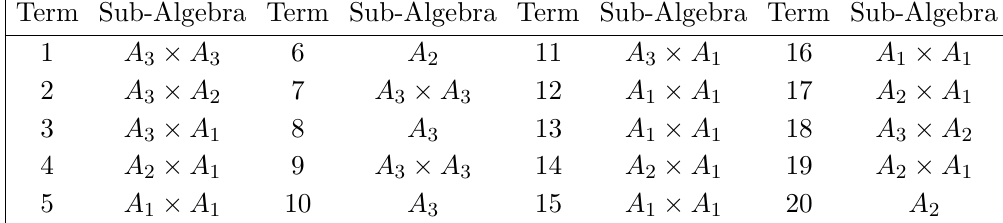
Table 4. Subalgebras associated to terms in A 8 ; 2